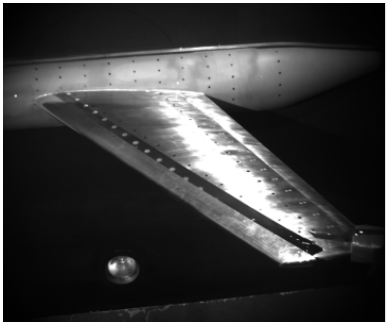
Figure 1. Example of the impact of ambient lighting on measurement of passive wing targets in a wind tunnel.